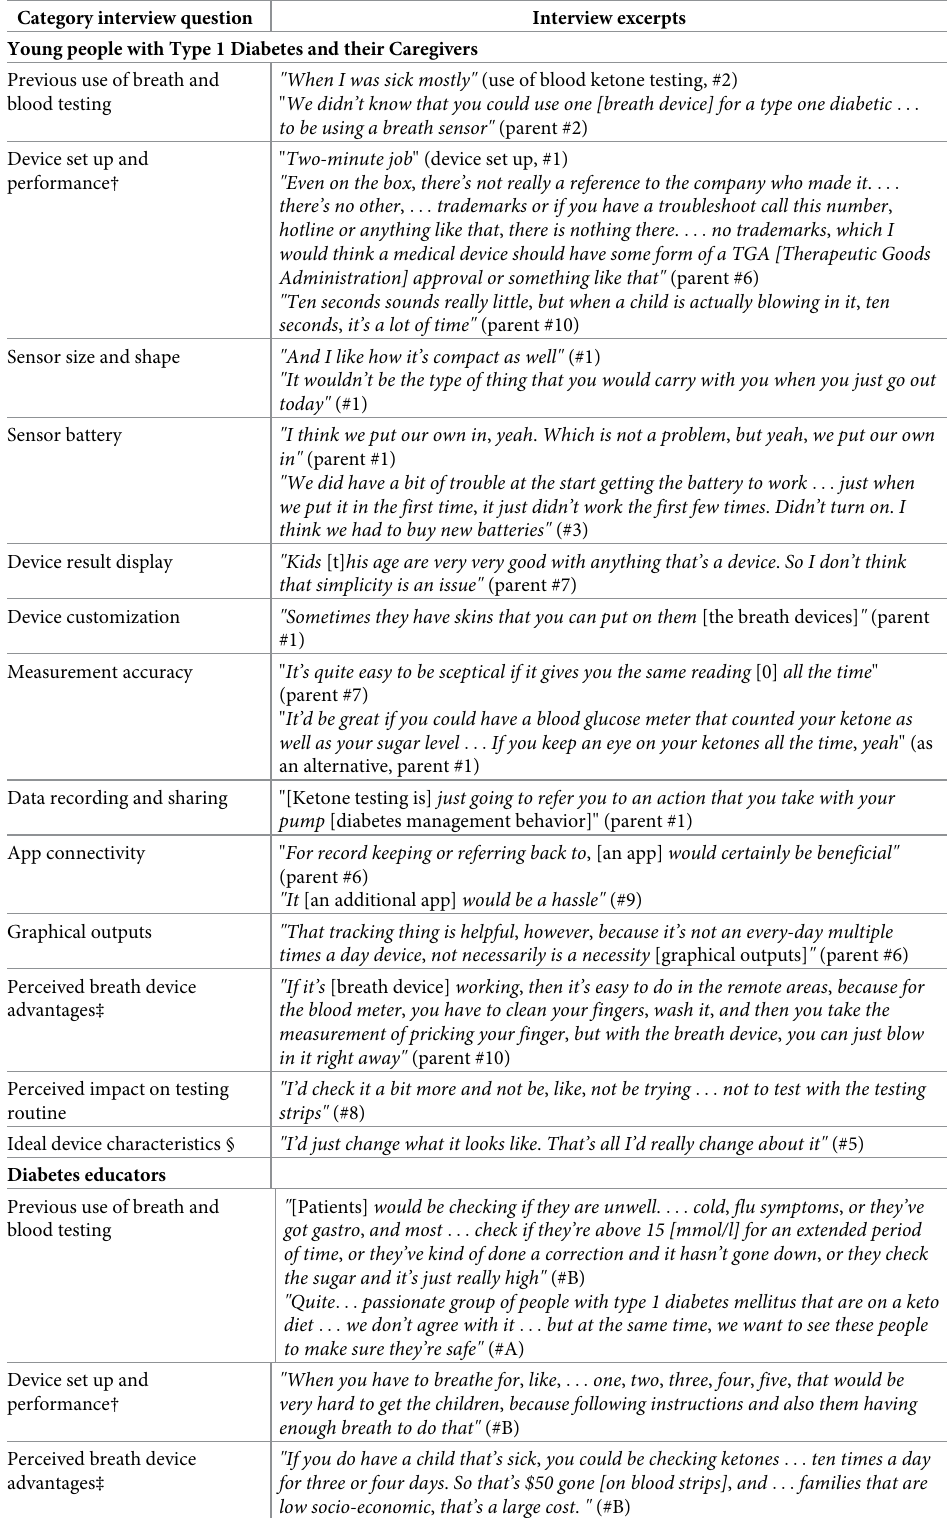
Table 4. Interview excerpt